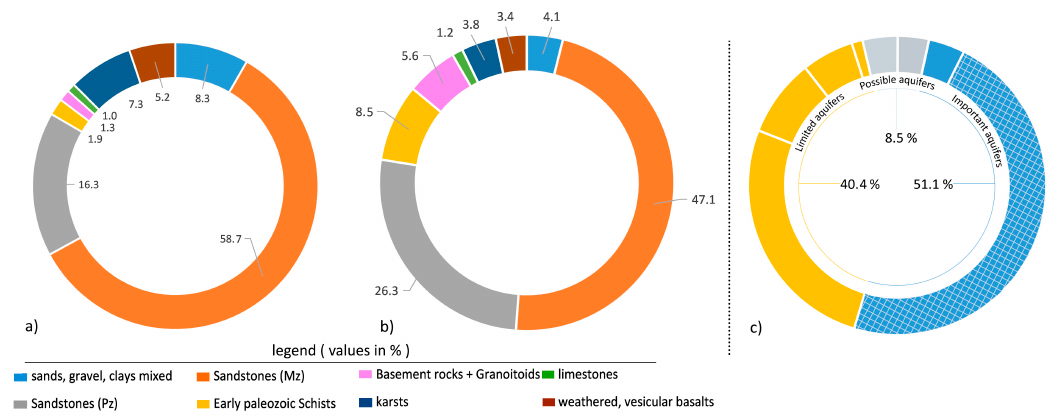
Figure 8. ( a ) Repartition of total shallow groundwater storage (%); ( b ) Relative significance of aquifers in terms of coverage in Laos (%); ( c ) Relative significance of limited, possible and important aquifers